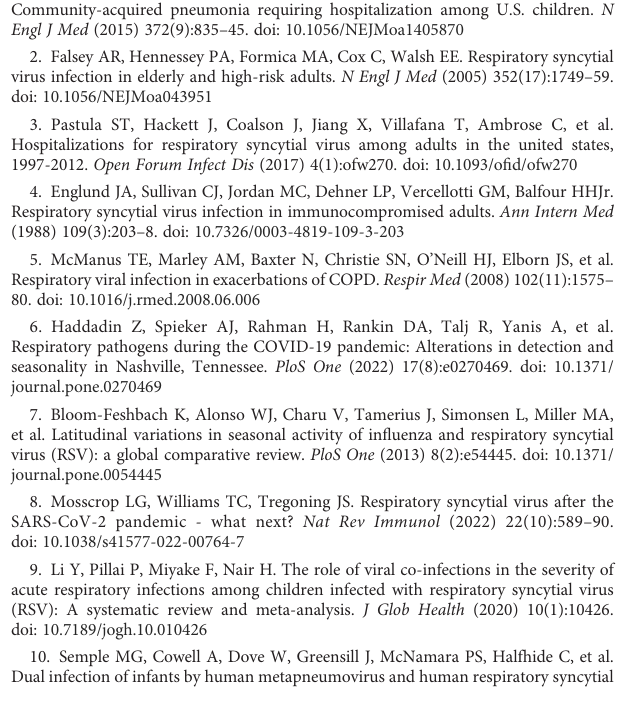
SUPPLEMENTARY TABLE 2 Logisticregressionmodelscomparingtheoddsofhospitalization,andamong those hospitalized, oxygen use, ICU admission, and intubation between children 0 – 4 years old with RSV single detection (reference group) and those with co-detection, including age at testing as a covariate. Values of p signi fi cant at a nominal value of a =0.05 are indicated in bold. RSV, respiratory syncytial virus; ICU, intensive care unit; OR, odds ratio; 95% CI, 95% con fi dence